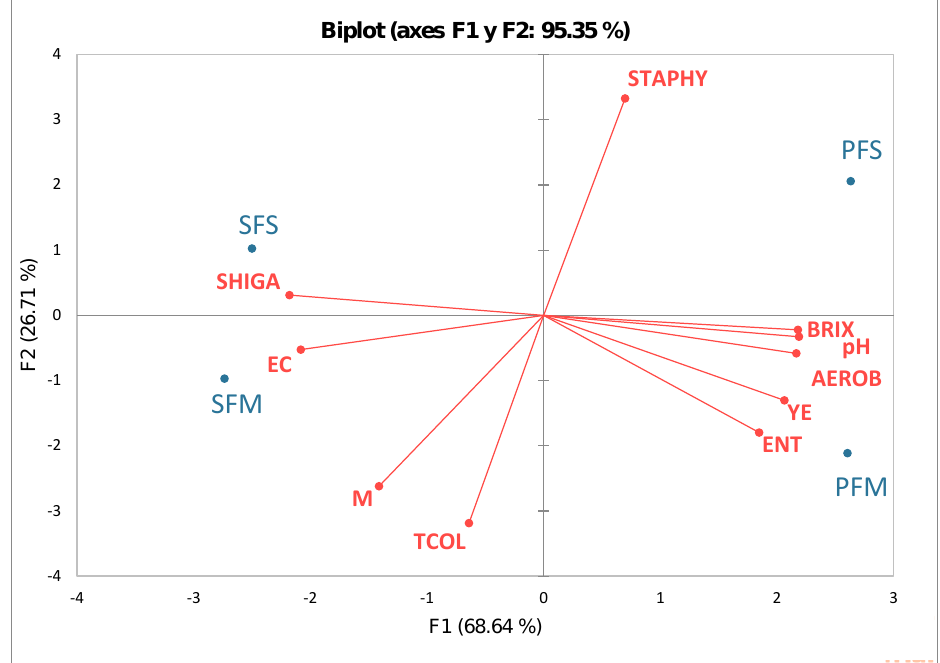
Figure 1. Biplot PCA analysis of 10 variables (pH, °Brix, TCOL, EC, AEROB, STAPHY, SHIGA, ENT, YE, M) of fruits at the ripening 6 stage. Legend: TCOL: total coliforms; EC: E. coli ., AEROB: total aerobes; STAPHY: Staphylococcus spp., SHIGA: Shigella spp., ENT: Enterobacter spp., YE: yeasts; M: molds; SFS-strawberries from a local farm grower; SFM: strawberries from low-cost market; PFS: gooseberries from a local farm grower; PFM: gooseberries from low-cost market. Red color: active variables; Blue color: active observations.